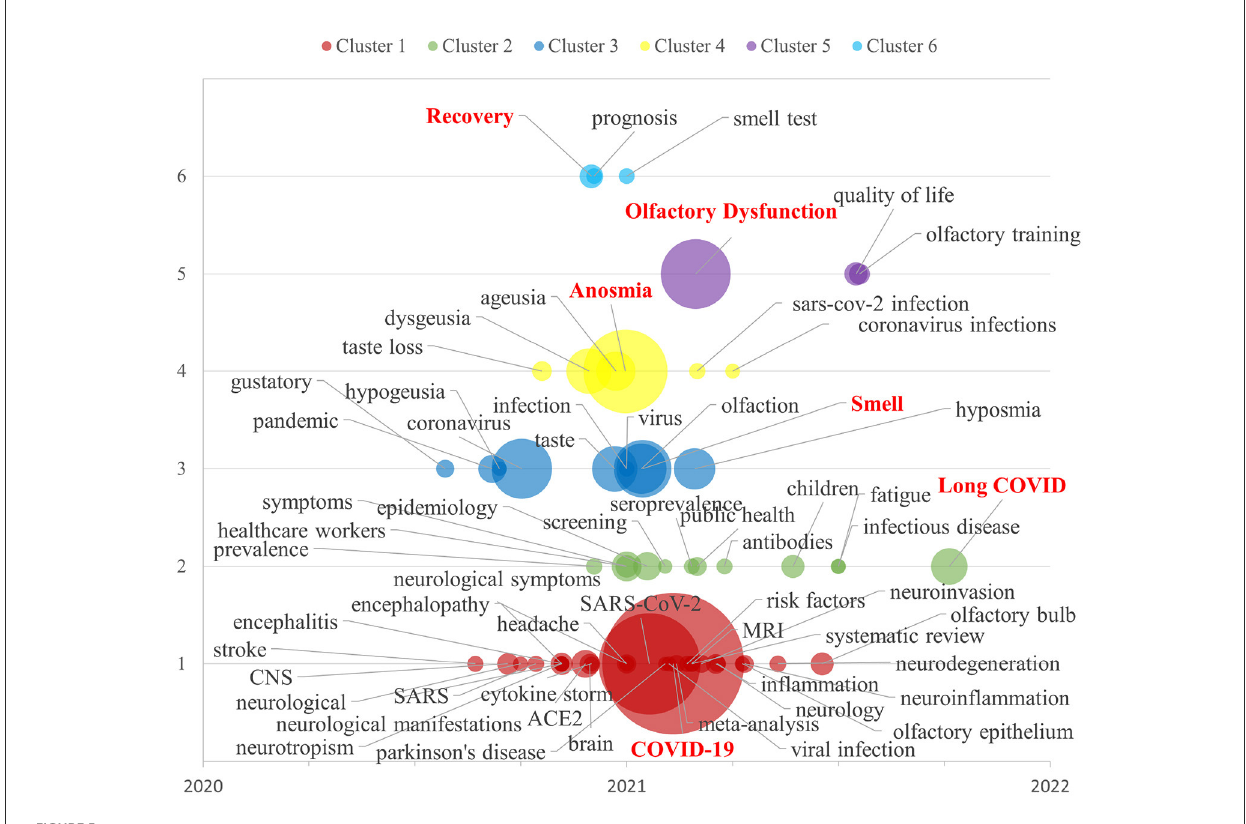
FIGURE5 The mapping of keywords temporal